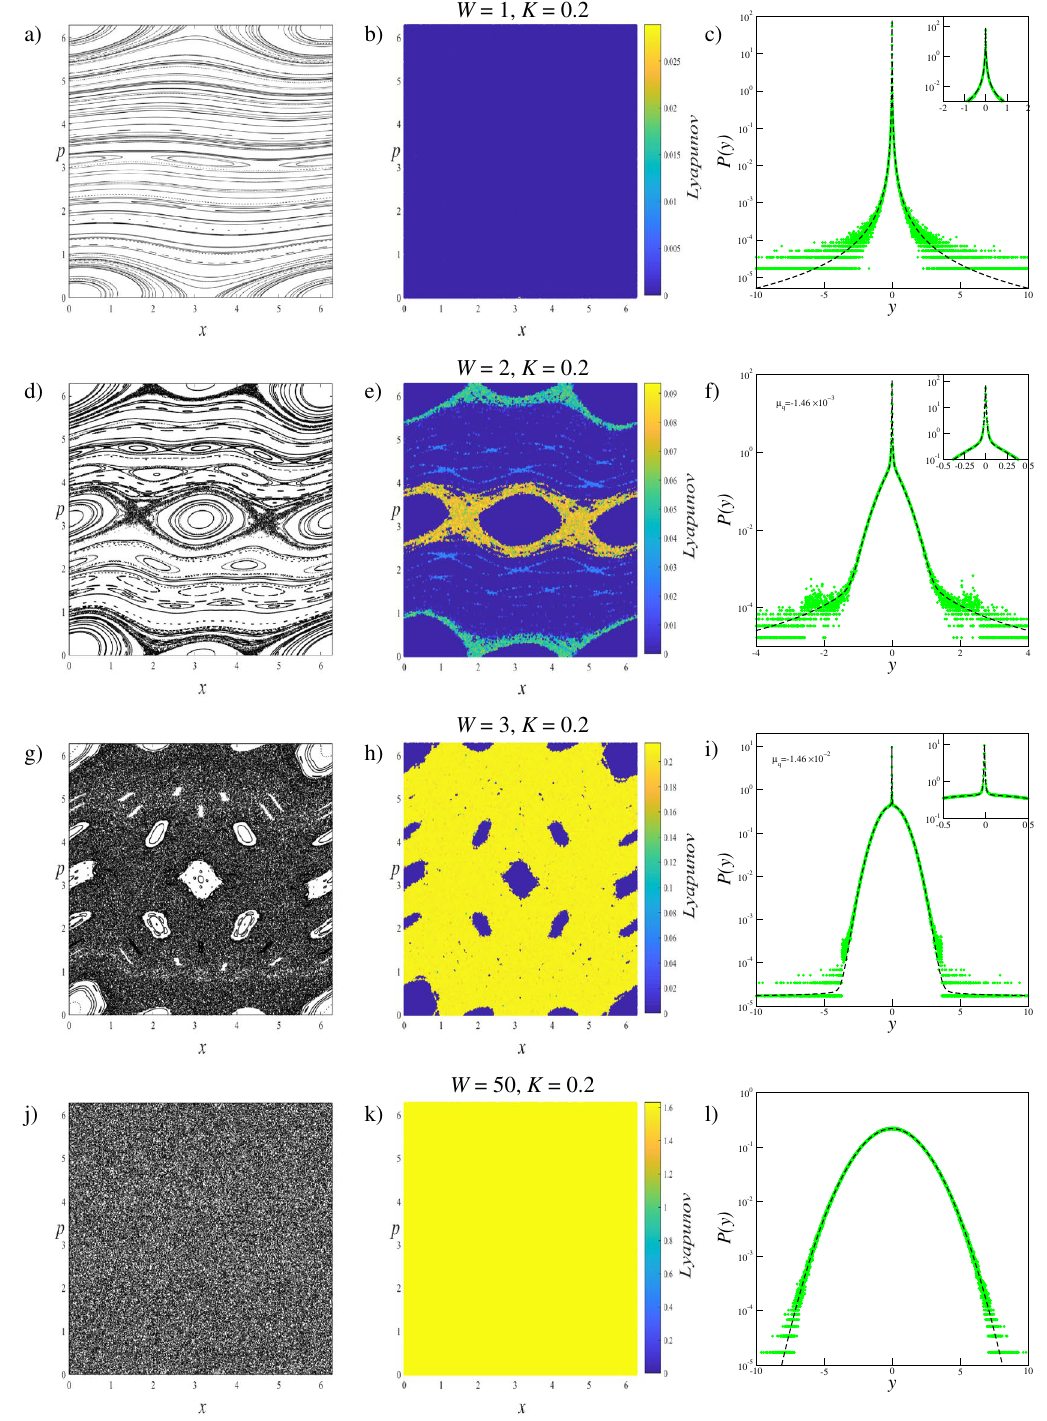
Figure 3. Analyses of the W = 1 , W = 2 , W = 3 , and W = 50 systems for K = 0.2 . Left column: ( a , d , g , j ) Phase space portraits, Middle column: ( b , e , h , k ) LLE color map descriptions of the phase portraits, Right column: ( c , f , i , l ) Probability distributions obtained from the initial conditions chosen from the entire phase